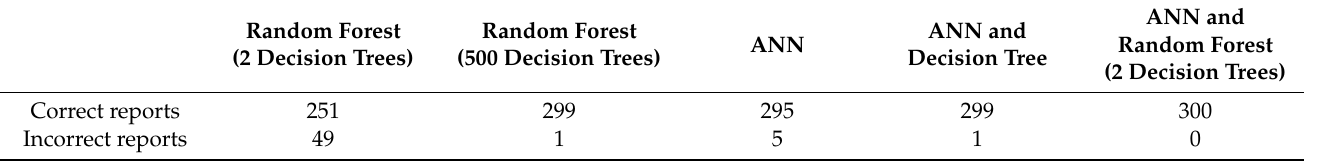
Table 5. Error diagnosis comparison for different methods.